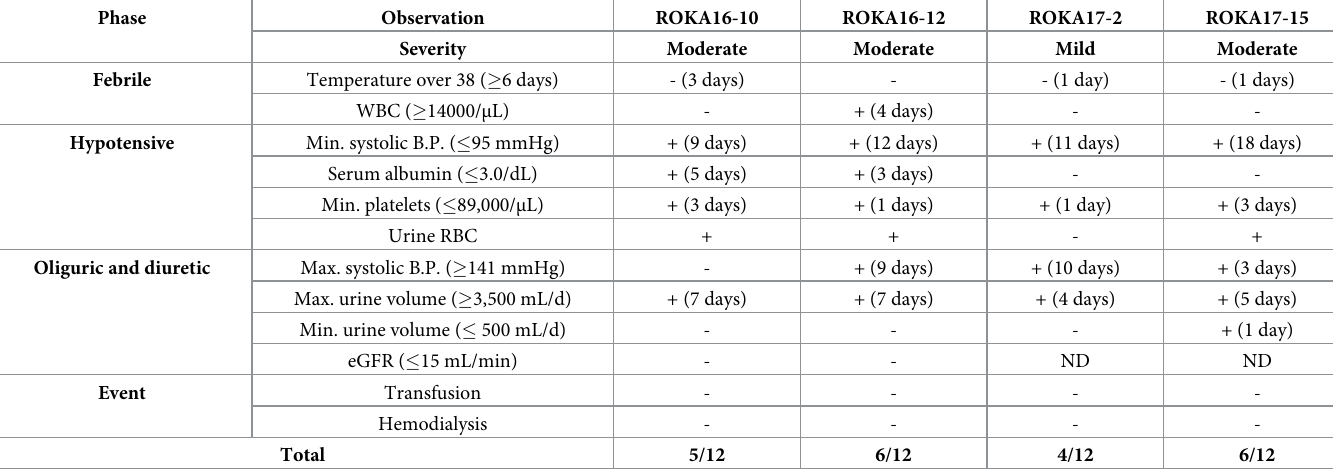
Table 3. Clinical outcomes and duration for hemorrhagic fever with renal syndrome (HFRS) patients. Phase